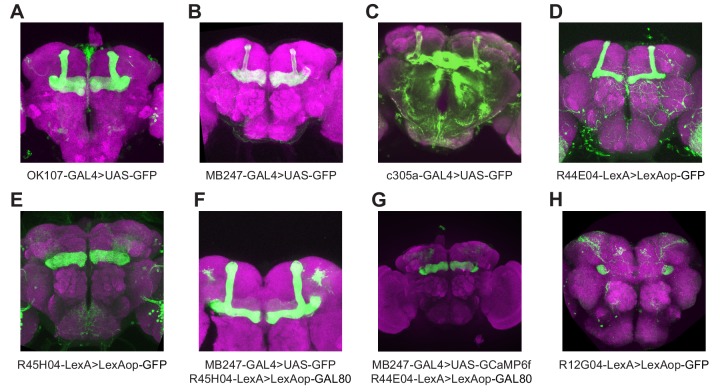
Expression patterns of GAL4 and LexA driver lines used in this study.GFP expression was driven by the named GAL4 or LexA driver lines and the general neuropil was stained with an antibody to NC82 (magenta). Images are maximum-intensity Z-projections of confocal stacks. Panels A-D, G show only the planes of the mushroom body lobes and peduncle to more clearly show which lobes are labeled. (A) OK107-GAL4 labels all KCs. (B) MB247-GAL4 labels αβ and γ KCs. (C) c305a-GAL4 labels α′β′ KCs. (D) R44E04-LexA labels αβ KCs. (E) R45H04-LexA strongly labels γ KCs. (F) Silencing MB247-GAL4 expression in γ KCs by using R45H04-LexA to drive lexAop-GAL80 in γ KCs results in fairly specific expression in αβ KCs. (G) Silencing MB247-GAL4 expression in αβ KCs by using R44E04 to drive lexAop-GAL80 in αβ KCs results in fairly specific expression in γ KCs. (H) R12G04-GAL4 labels MBON-γ1pedc>α/β, aka MB-MVP2.